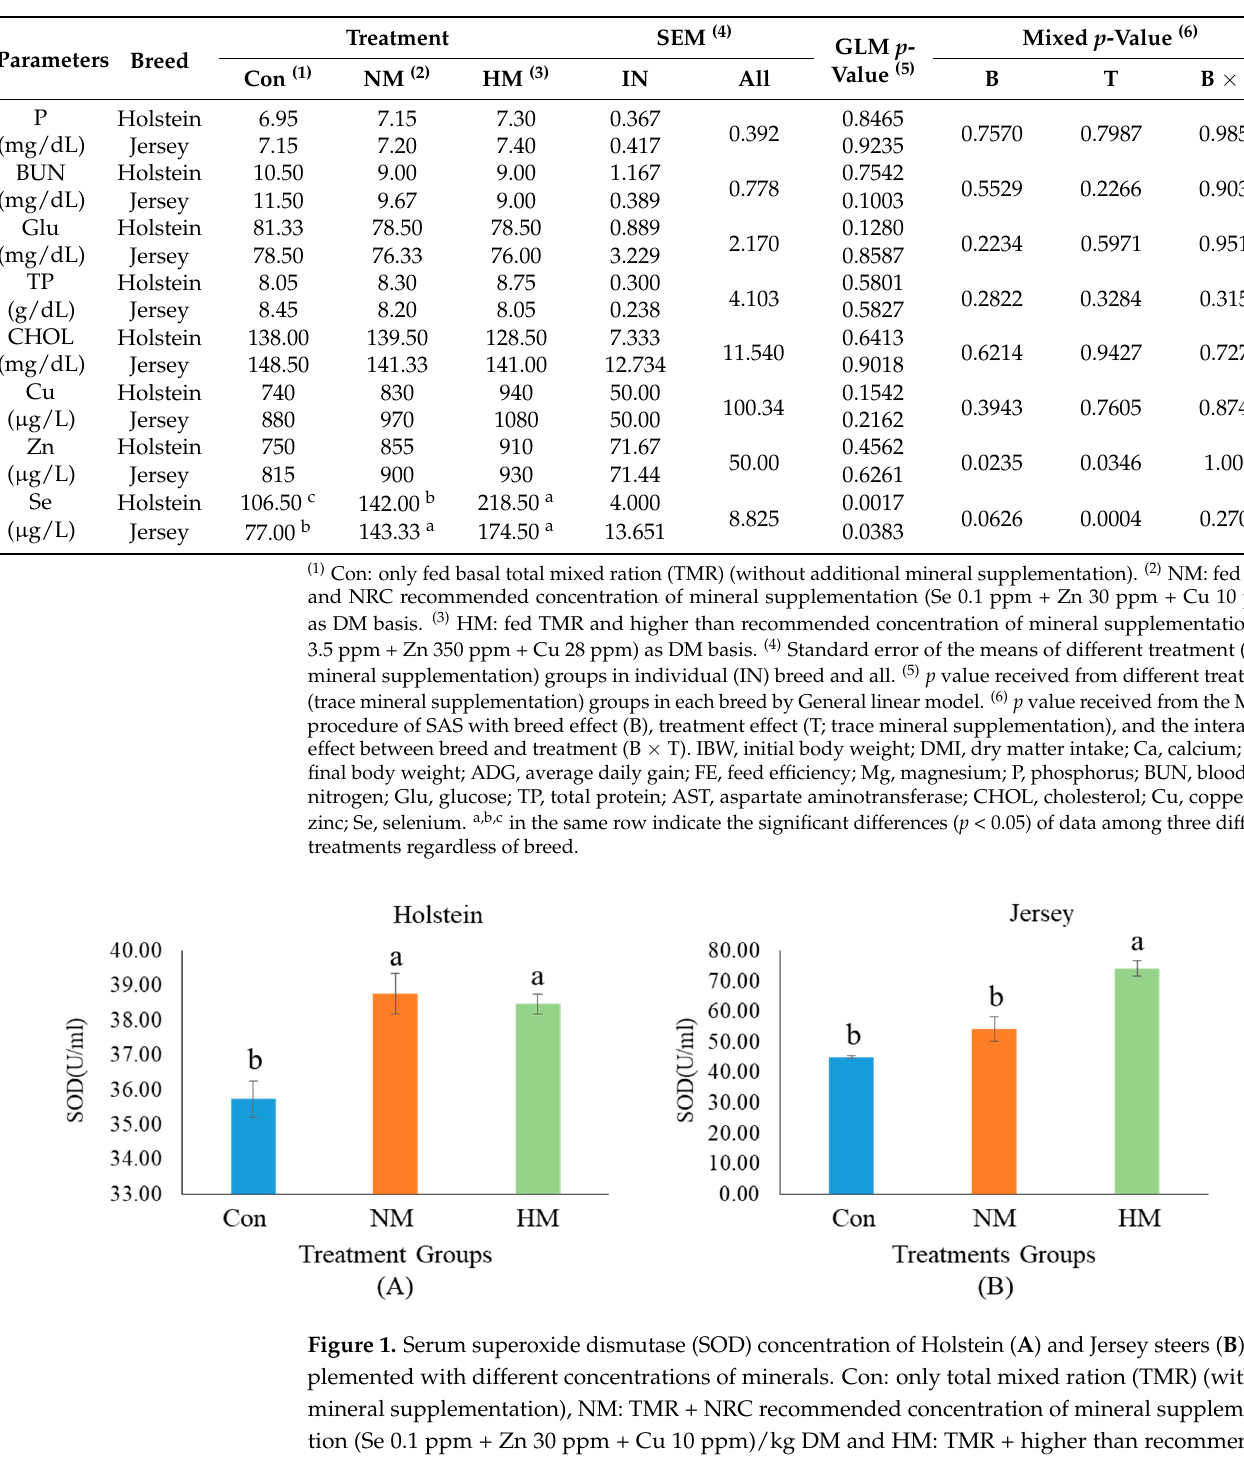
Figure 2. Serum concentrations of heat-shock proteins (HSPs) in Holstein ( A , C ) and Jersey steers ( B , D ) supplemented with different concentration of minerals. Con: only TMR (without mineral sup- plementation), NM: TMR + NRC recommended concentration of mineral supplementation (Se 0.1 ppm + Zn 30 ppm + Cu 10 ppm)/kg DM and HM: TMR + higher than recommended concentration of mineral supplementation (Se 3.5 ppm + Zn 350 ppm + Cu 28 ppm)/kg DM. The symbols a and b above the error bars in each figure indicate significant ( p < 0.05) differences among treatment groups. 3.2. Serum Metabolites